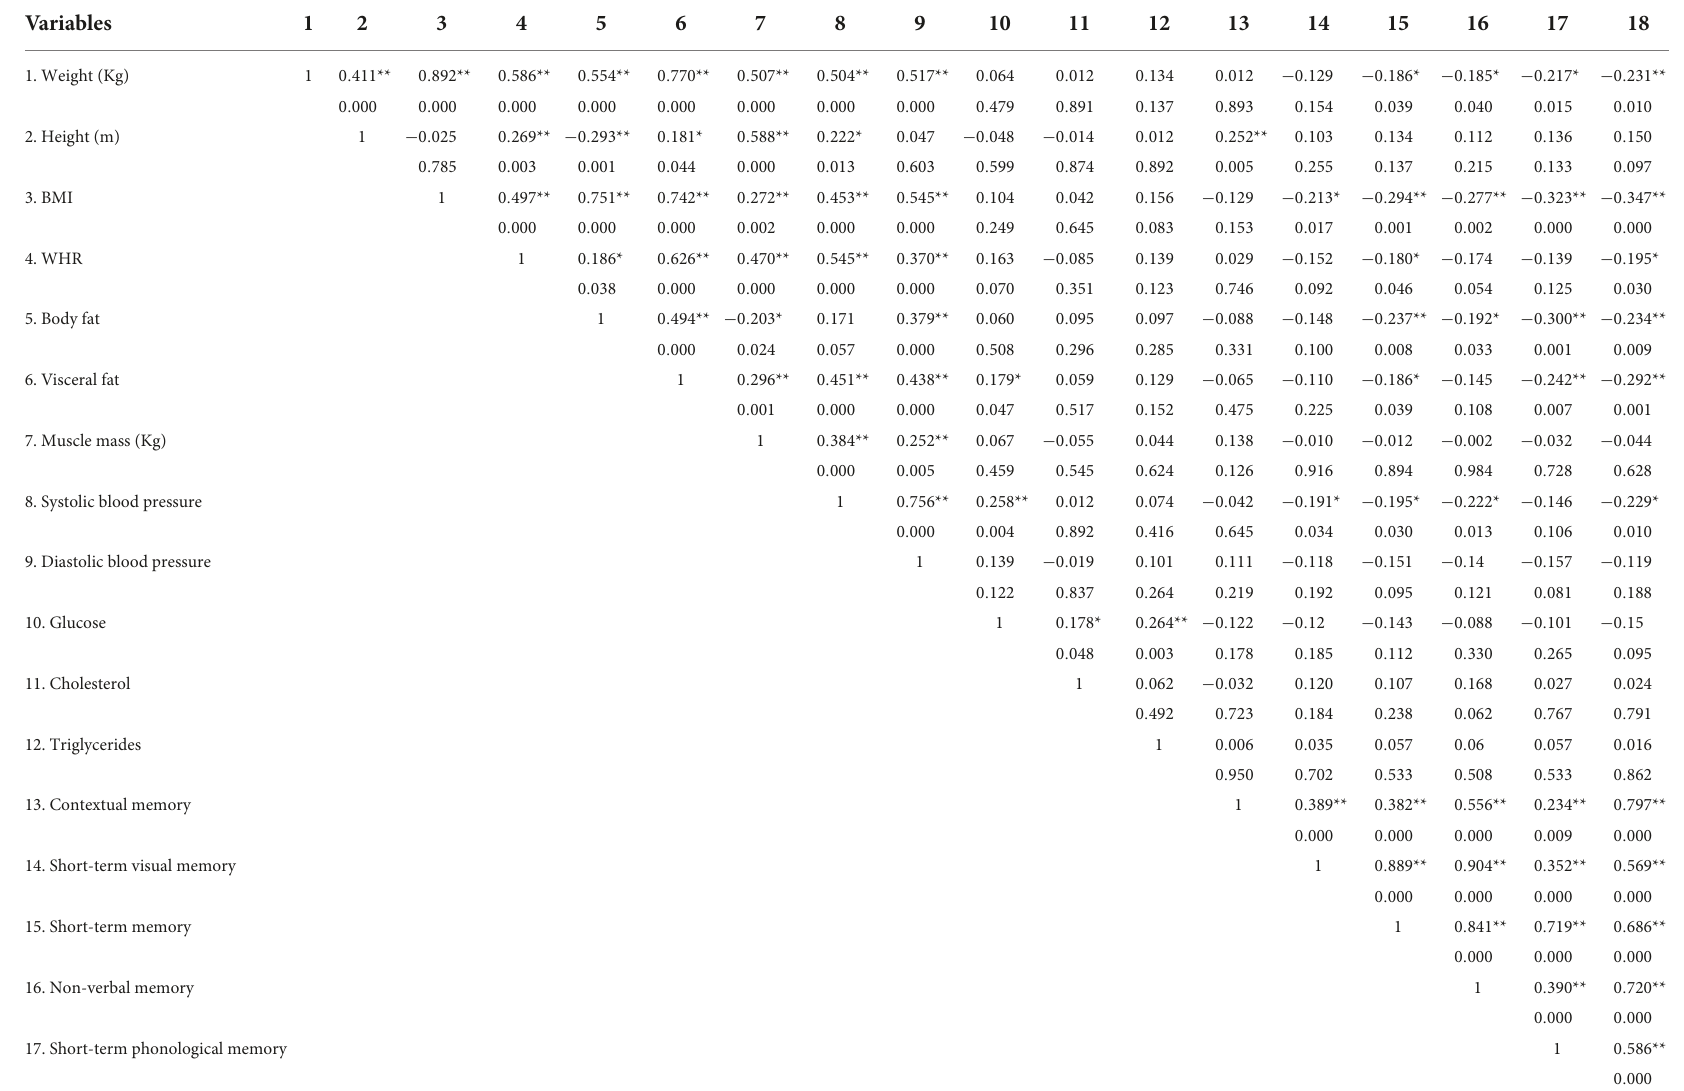
TABLE 2 Bivariate correlations between clinical and anthropometric measures and